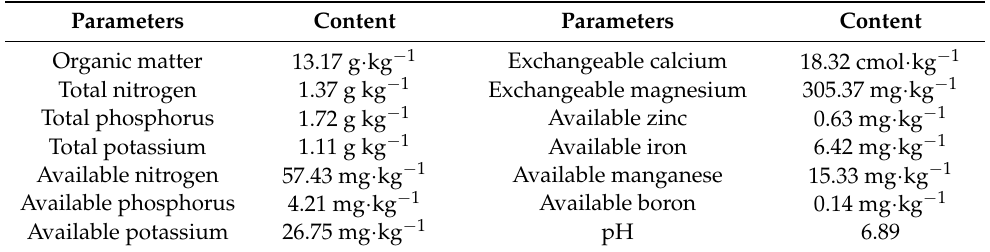
Table 1. The physical and chemical characteristics of planting soils of R. roxburghii